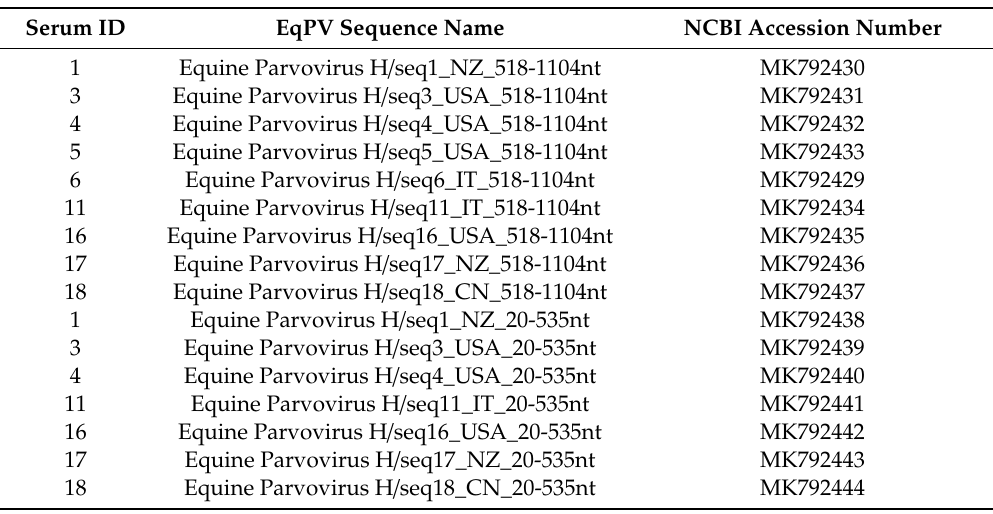
Equine Parvovirus H / seq16_USA_518-1104nt